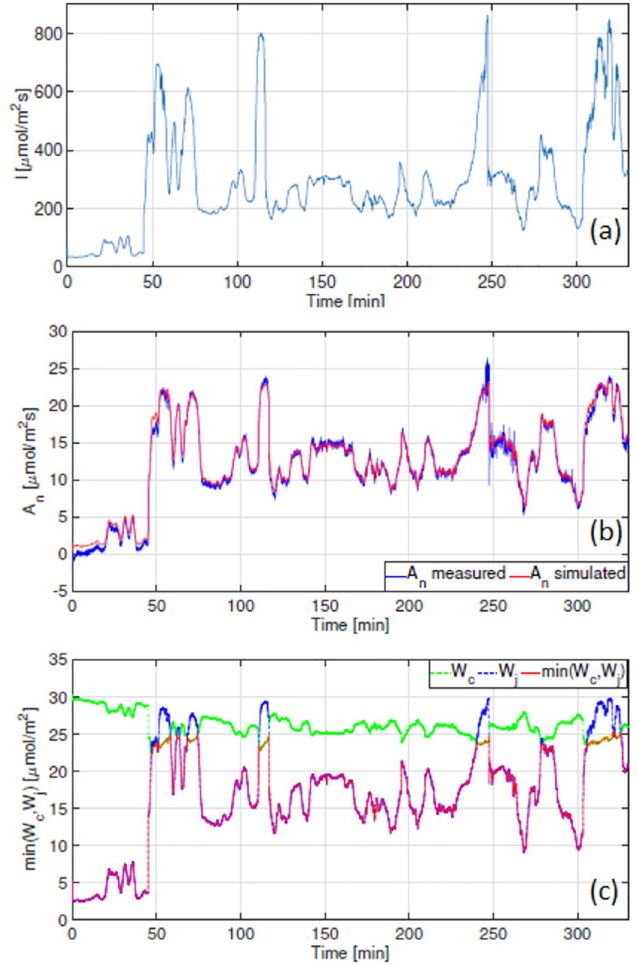
Fig 7. Model validation results obtained for measurements taken on 6 Sept 2021 with c a = 400ppm. (a) Measured irradiance μmolm − 2 s − 1 . (b) Net photosynthetic rate μmolm − 2 s − 1 (c) min(W photosynthesis is limited by the carboxylation or electron transport